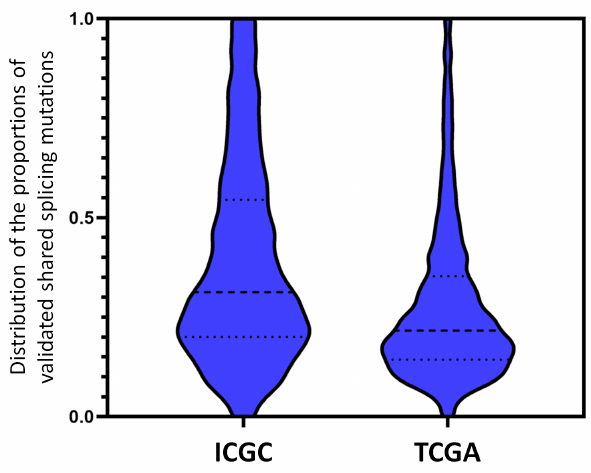
Figure 3. Census of Recurrent Splicing Mutations Present in Multiple ICGC and TCGA Patients. Predicted splicing mutations present in multiple tumors from the same dataset that cause splicing abnormalities were analyzed to determine validation rates, since such variants were less subject to technical artifacts, such as sequencing errors. Violin plots indicate the distributions of the fraction of predicted and validated splicing mutations present in multiple patients relative to the total number of tumours carrying those mutations in the TCGA and ICGA datasets. To achieve statistical significance (95% C.I.), distributions of 1,379 validated variants shared by both datasets and present in at least 9 ICGC (left) and 24 TCGA (right) patients were compared. A higher overall proportion of mutations are validated in the ICGC dataset (average of 38.6% for ICGC and 27.8% for TCGA). The dashed lines in each plot indicate the median (middle line), the upper and lower quartiles of the mutation